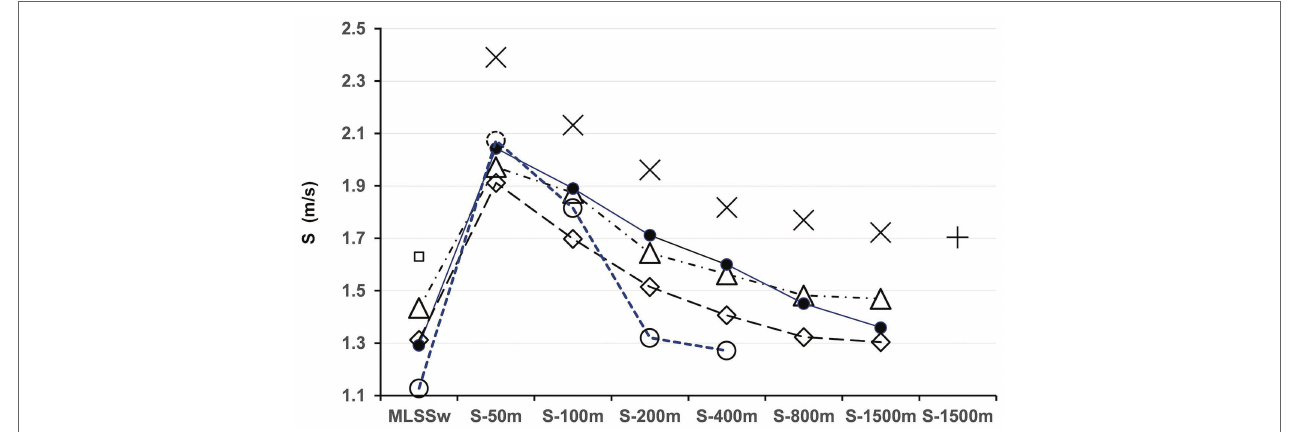
FIGURE 5 | Comparison of swimming performance in relation to maximal lactate steady state workload (MLSS W ) across Olympic distances. ▲ = Test person (TP) 1, ● = TP 2, ◊ = TP3, ○ = TP4, □ = estimated MLSS W Australian National Team 1996, according to Pyne et al. (2001), + = world record 1994 (Kieren Perkins, Australia), X = current world records (FINA, F.I.d.N., 2021). TP1 had the highest MLSS W , resulting in comparatively good results across all distances. TP4 was slightly faster at 50 m, but slowed down rapidly at longer distances. Note that TP2 performed close to the MLSS W in the 1,500 m race ( ∆ S-Comp/MLSS W = − 0.008 m/s). ∆ S-Comp/ MLSS W for TP1/TP3 was moderate (0.035/0.067 m/s) with a relatively high MLSS W for TP1 and a relatively low MLSS W for TP3 (1.434/1.387 m/s; for a detailed analysis see section “Discussion”). Since MLSS W data from world record holders were not available, we estimated the values using data from Pyne et al. (2001). Although these calculations are certainly not entirely accurate, they clearly demonstrate the large gap between MLSS W1996 and the 1,500 m world record in 1994. S,